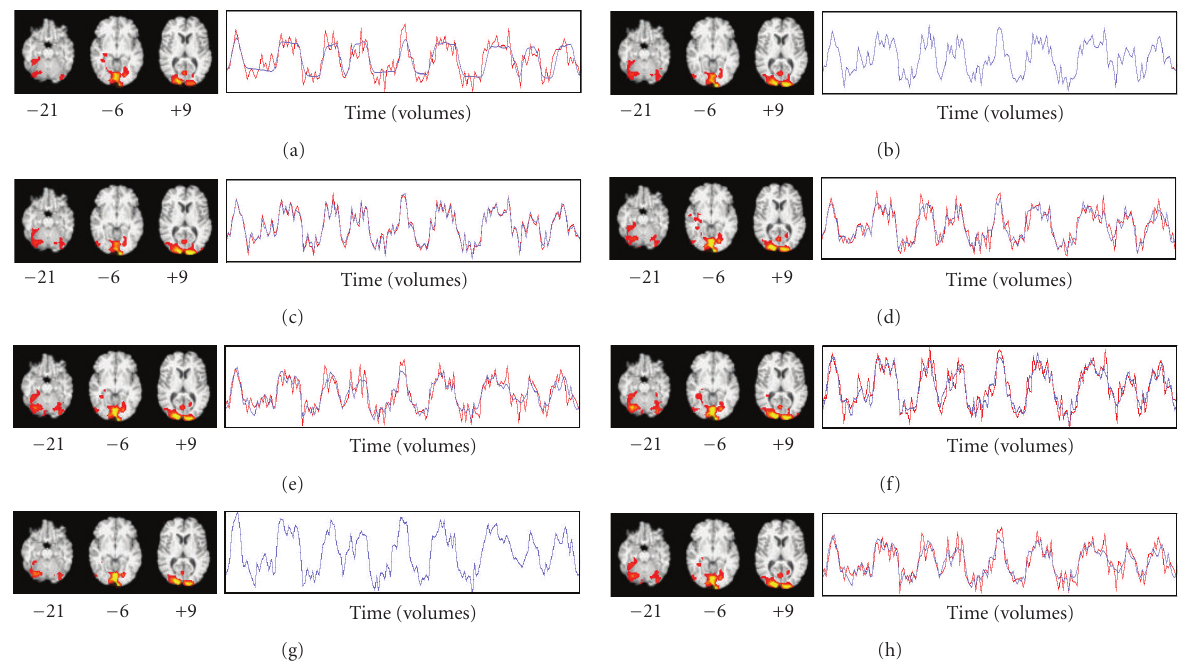
Figure 3: Spatial maps and time courses for Run 3, derived from (a) task-related GLM; hybrid ICA-seed-based approaches using the average time course from (b) a single voxel, (c) a few voxels, or (d) many voxels; dual regression using seed spatial information from (e) an IC spatial map or (f) an entire set of IC spatial maps; (g) ICA; and (h) regression of the fMRI data against the IC time course. Run 3 was the source of seed spatial